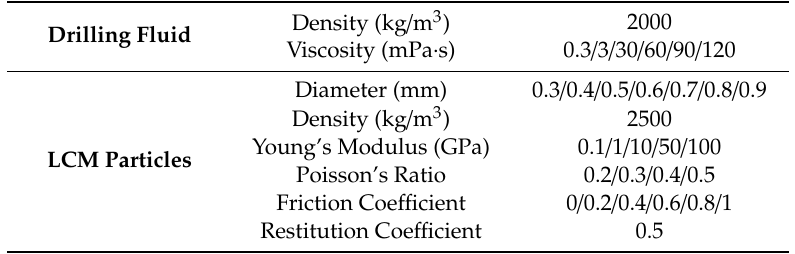
Table 3. Properties of drilling fluid and particles (base / reference case in bold and